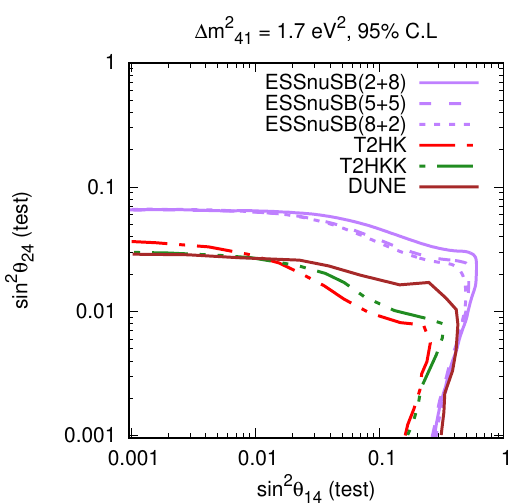
Figure 4 . Comparison of ESSnuSB with other long-baseline neutrino oscillation experiments. This plot is for an FD only with 8 % overall systematic error in the signal and 10 % overall systematic error in the